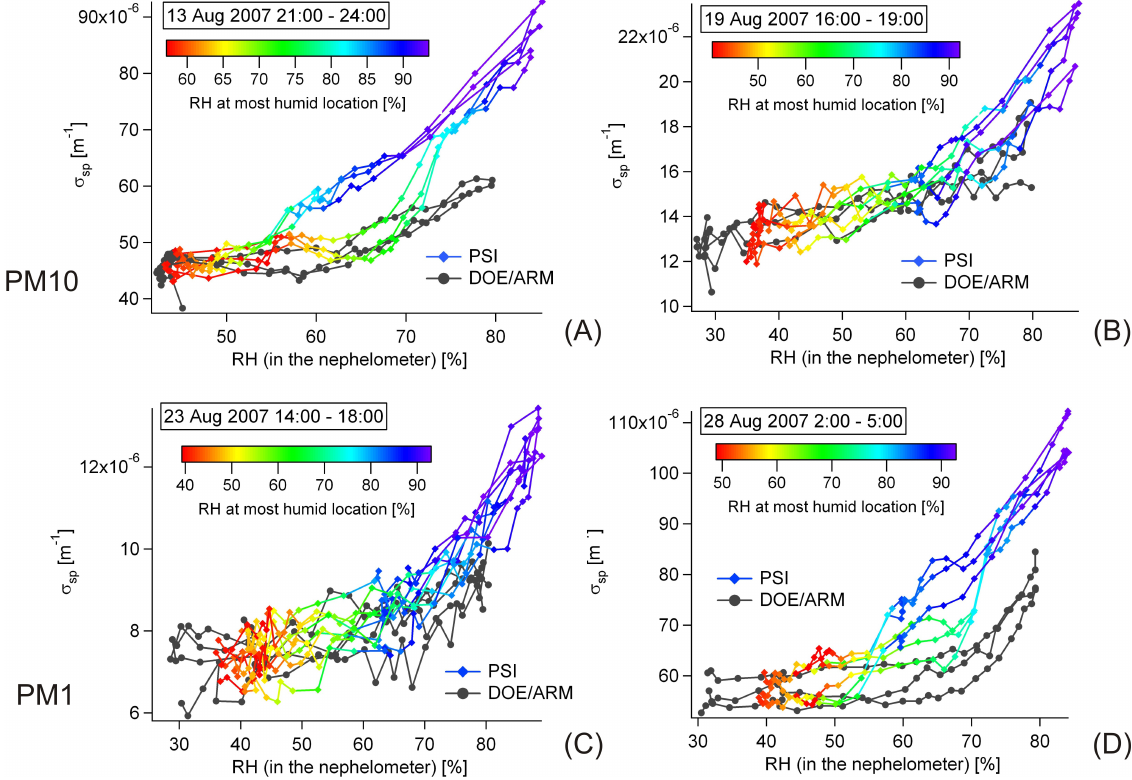
Fig. 5. Humidograms of the scattering coefficient vs. RH in the nephelometer at four selected time periods for PM 10 ( A and B ) and PM 1 ( C and D ). The black curves are measured by the DOE/ARM humidified nephelometer. The colored curves show σ sp from the PSI humidified nephelometer, where the color represents the RH at the most humid location in its system (RH 3 ). Hysteresis behavior is seen in humidograms (A) and (D).